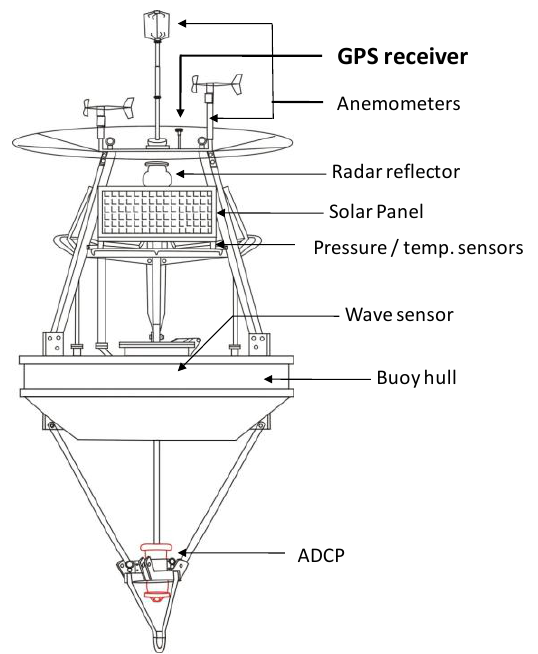
Figure 1. Sketch of the GPS